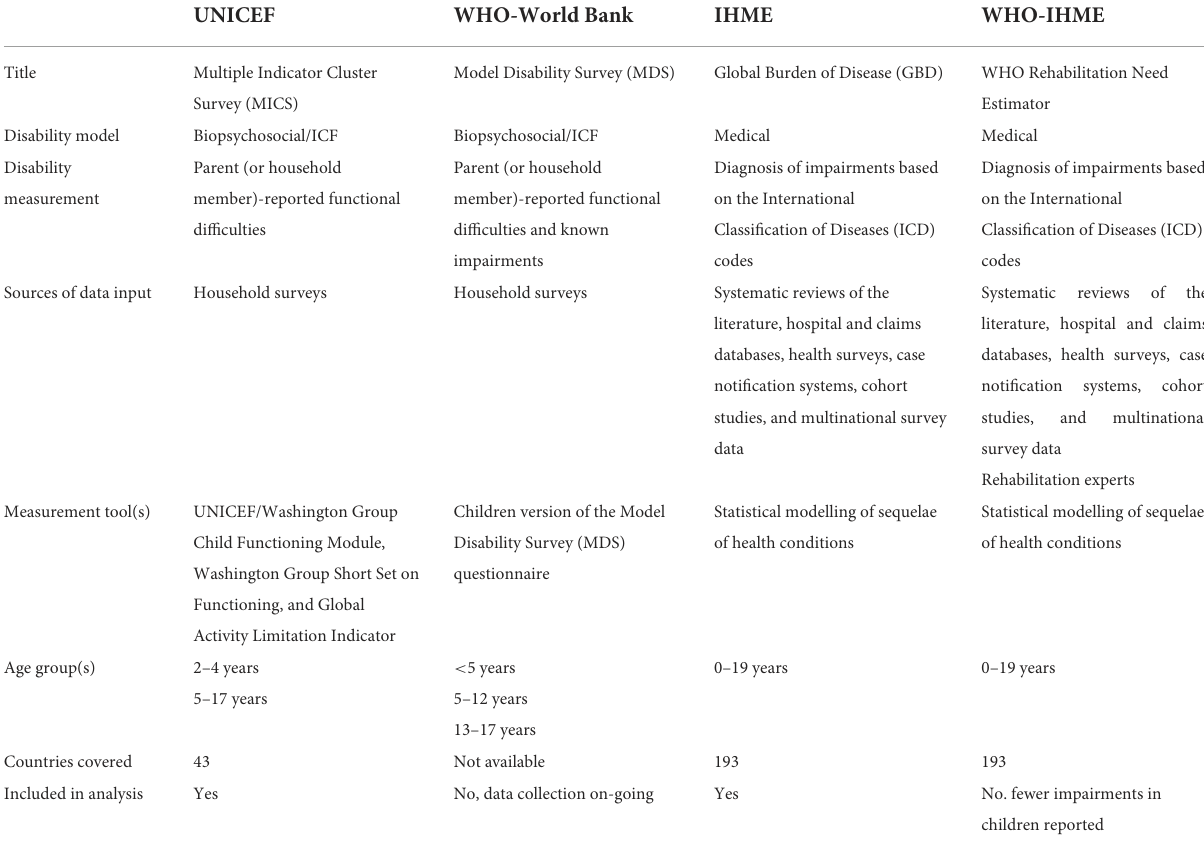
TABLE 1 Summary of data sources for global estimates of disabilities in children and